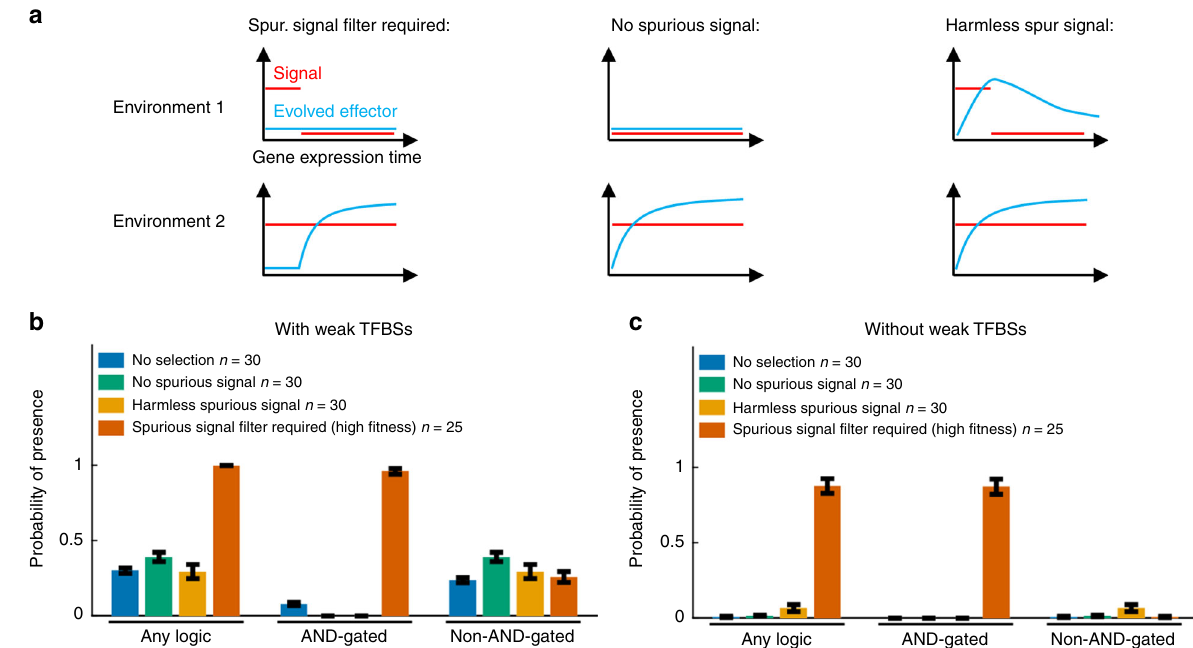
Fig. 6 Selection for fi ltering out short spurious signals is the primary cause of C1-FFLs. TRNs are evolved under different selection conditions, and we score the probability that at least one C1-FFL is present (see Supplementary Methods). Schematics of selection, in which fi tness is averaged with weights 2:1 over environment 1:2, are shown in ( a ). The effector is deleterious in environment 1 except in the “ harmless ” and “ no selection ” conditions. Weak (two- mismatch) TFBSs are included in ( b ) and are excluded in ( c ) during motif scoring. Data are shown as mean ± s.e.m. over evolutionary replicates. C1-FFL occurrence is similar for high- fi tness and low- fi tness outcomes in control selective conditions (Supplementary Fig. 5), and so all evolutionary outcomes were combined. “ Spurious signal fi lter required (high fi tness) ” uses the same data as in Fig.